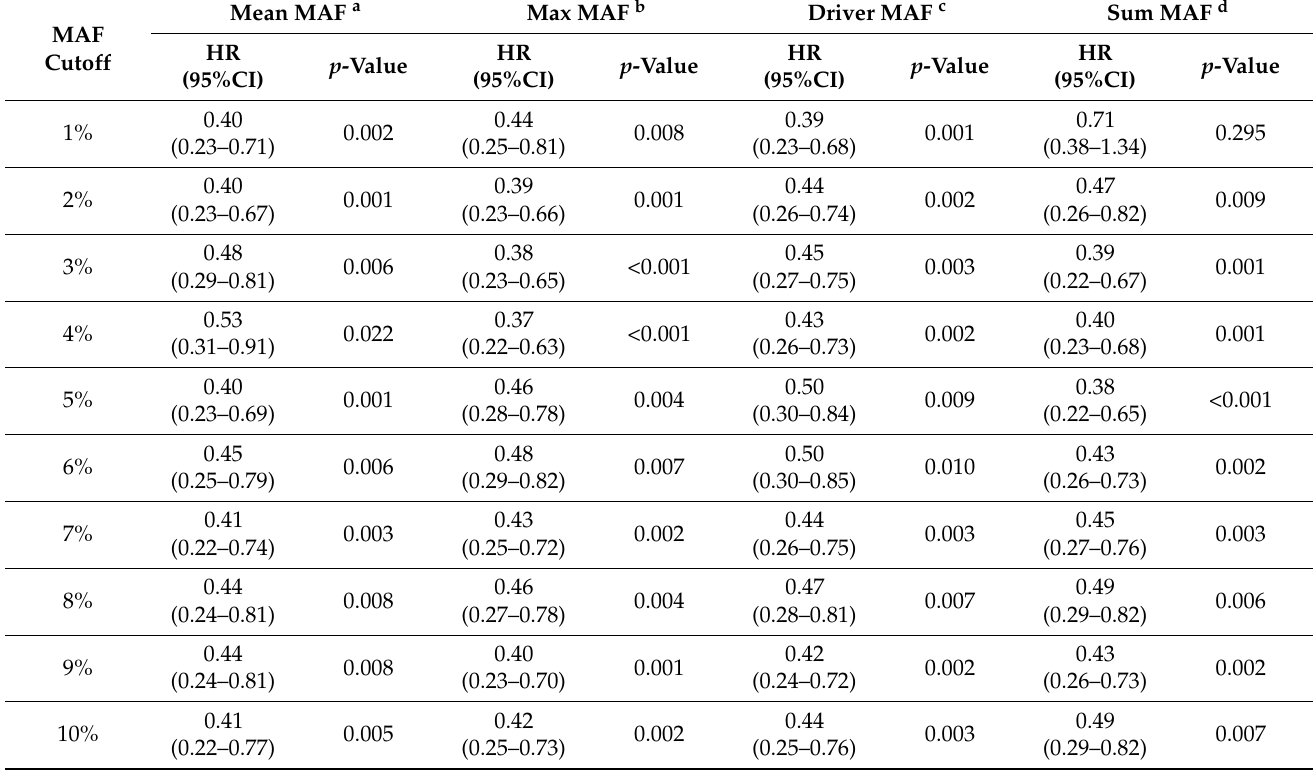
Table 4. HR and corresponding 95% CI according to MAF cutoff assessed using four differ- ent